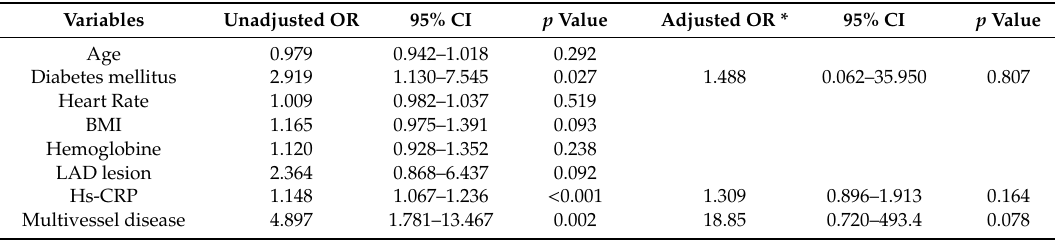
Table 3. E ff ects of variables on angiographic no-reflow in univariate and multivariate logistic regression